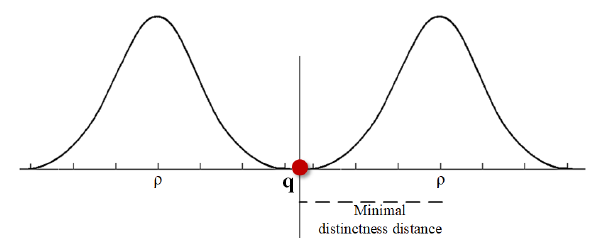
Figure 2. Weighting function for saliency detection: a center-surround filter that emphasizes regions at a distance ρ while suppressing closer and distant features, a 2-D view.